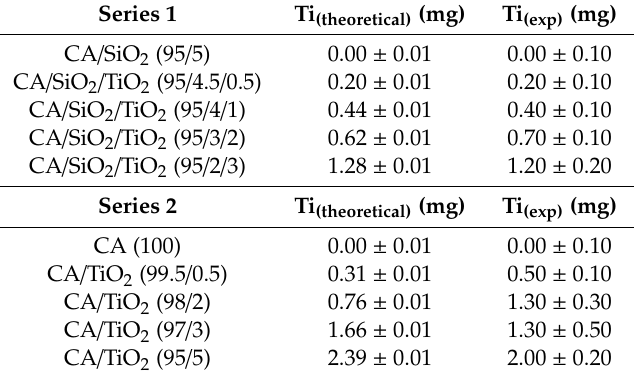
Table 2. Ti present in casting solutions (Ti theoretical ) and in the membranes (Ti experimental ) from series 1 and